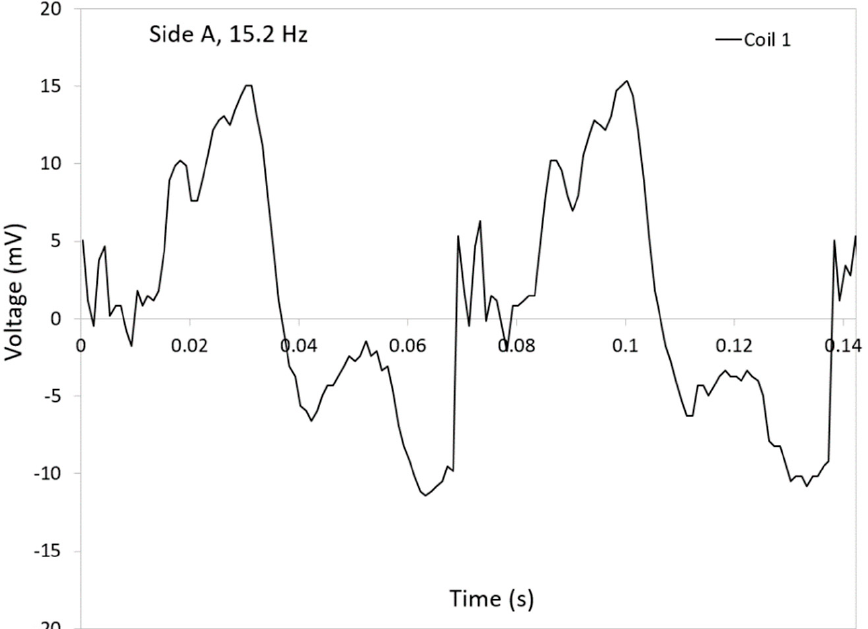
Figure 8. Expanded graphs of the generated voltages in coil 1 as a function of time when the side A of the harvester is subjected to a compression at 15.2 Hz rate.